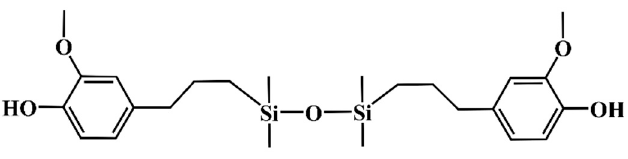
Figure 1. Structure of 4,4’-(1,3-dipropyl-tetramethyldisiloxane)bis-2-methoxyphenol (SIE).